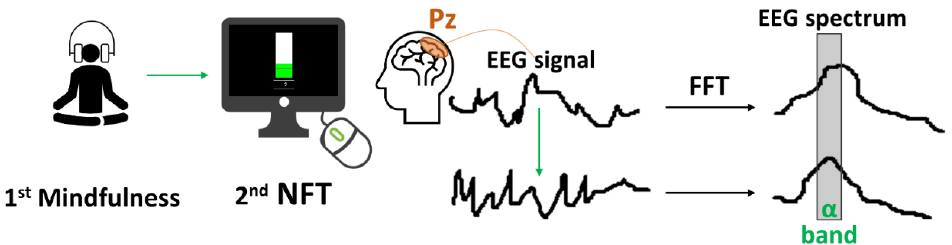
Figure 3. Objective diagram. The external mindfulness stimuli prime the subject to facilitate/scaffold the transition to the target brain activity alpha ( α ) in the Pz channel during NFT. The EEG spectrum physiological change is also represented.